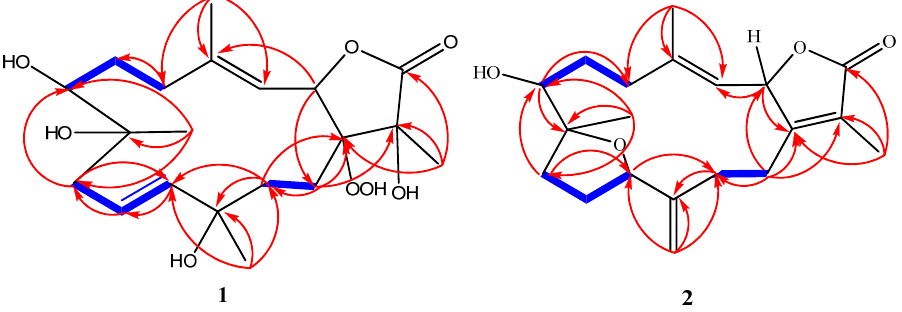
Figure 2. Observed 1 H- 1 H COSY (bold blue line) and HMBC (red arrow) correlations for ( 1 ) and ( 2 ). A combination of the intensity of the 1 H and 13 C NMR signals for 2 , together with the [M] + ion at m / z = 332.1991 (calcd. 332.2222) in the HREI mass spectrum, supported a chem- ical formula of C 20 H 28 O 4 corresponding to seven double bond equivalents. Compound 2 − 3.4 in methanol. was produced as a colorless oil with a negative optical rotation of [ α ] 25 D The IR spectra revealed two distinct bands at 3450 cm − 1 (OH) and 1750 cm − 1 (CO). The 13 C NMR spectrum displayed twenty carbon signals (Table 1), which were further differ- entiated by DEPT to three methyls (one oxygenated at δ C 19.8 and two olephenic at δ C 8.8, 20.7), seven methylenes (one exomethelene at δ C 111.1 and six aliphatic at δ C